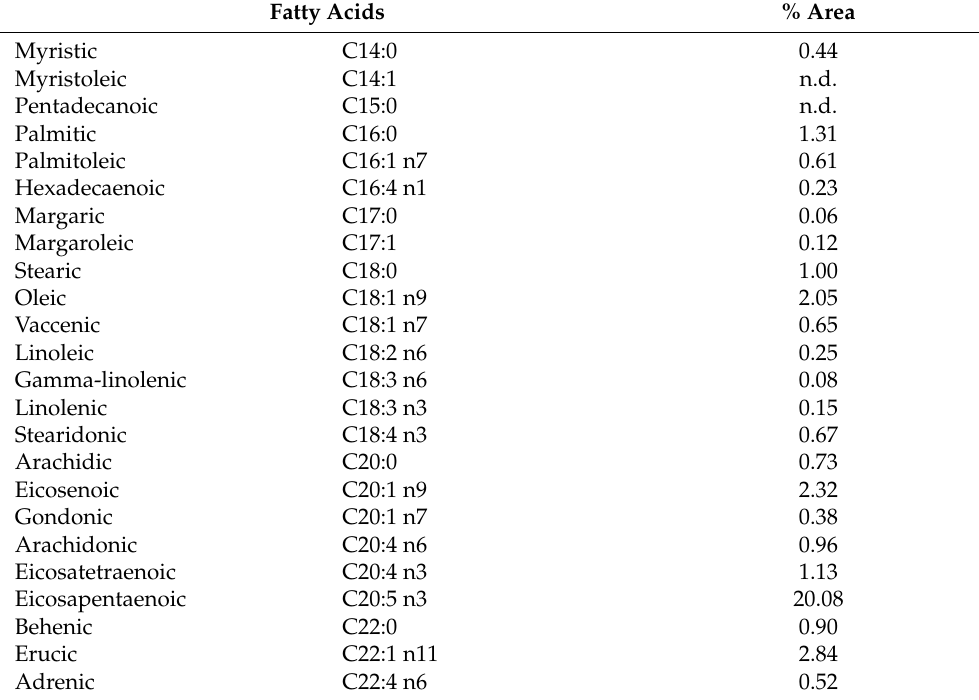
Table 1. Essential fatty acids in the Lipinova-11TG batch. Data are represented as % area. Fatty Acids %